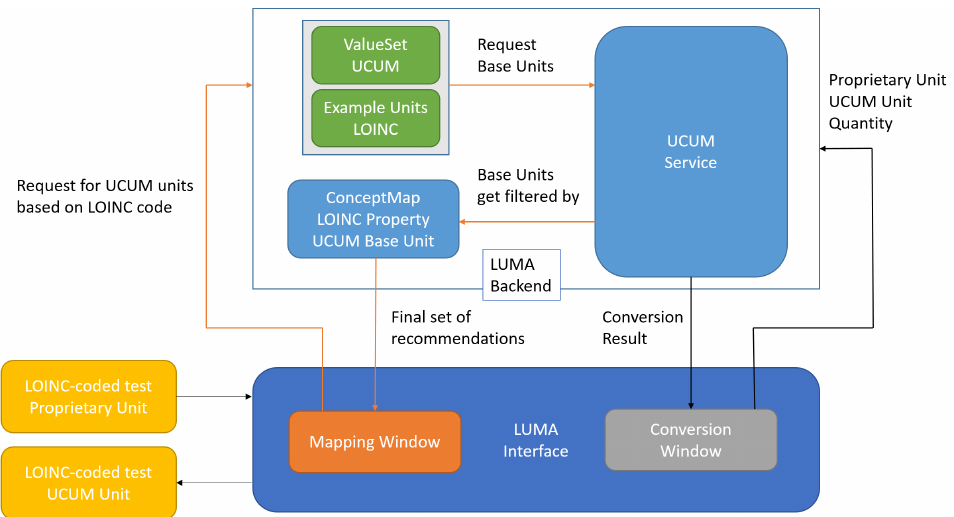
Figure 2. This figure outlines the rough interplay between the components. Specific implementation details have been